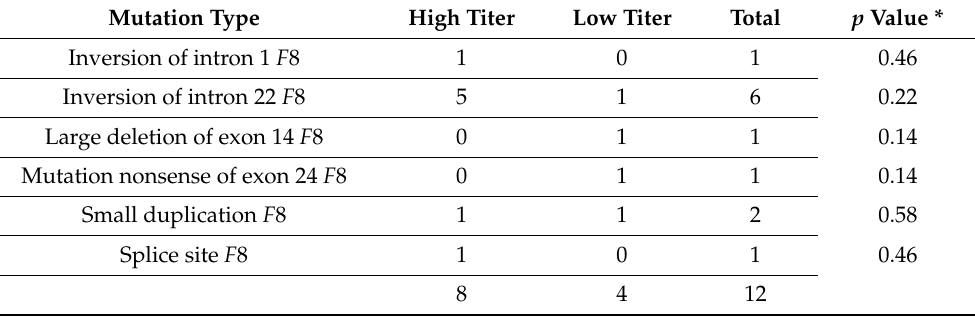
Table 3. Association between type of mutation and presence or absence of inhibitors.